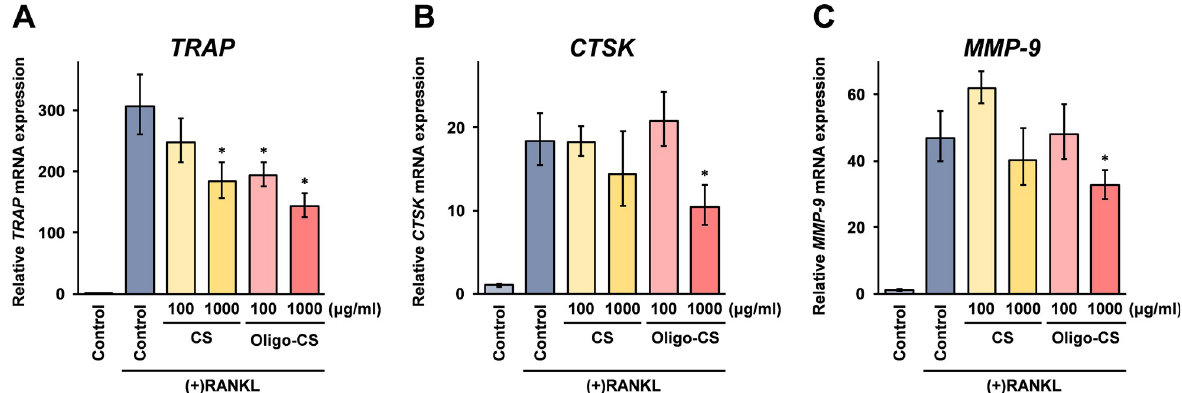
Fig 3. Effects of Oligo-CS treatment on TRAP, CTSK, and MMP-1 mRNA expression in osteoclast differentiating RAW264 cells. RAW264 cells were stimulated with sRANKL to differentiate osteoclasts together with indicated concentrations of CS or Oligo-CS for 5 days. The total RNA isolated from the cells was subjected to real-time RT-PCR analysis using the respective specific primer set for TRAP, CTSK, and MMP-9 mRNA. The data indicate the relative expressions compared with untreated control cells without sRANKL stimulation after normalization with the GAPDH mRNA expression. Error bars indicate the standard deviations (n = 3). Asterisks ( * : p < 0.05) indicate that the difference is statistically significantly lower than the sRANKL stimulated control.